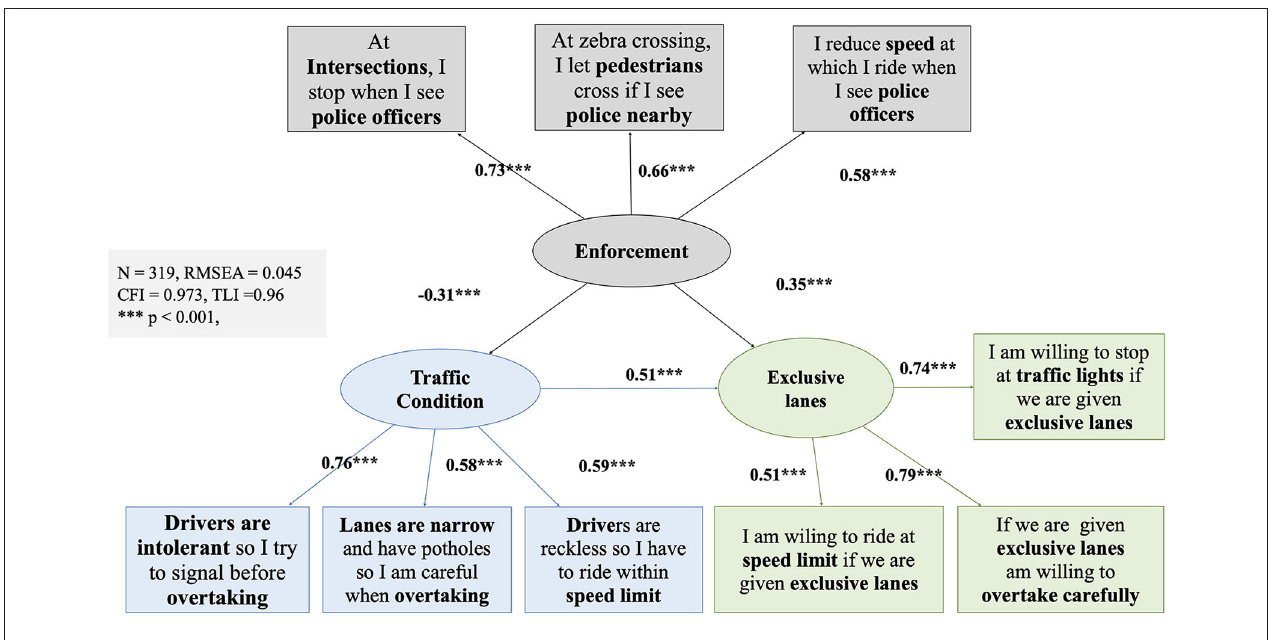
FIGURE 7 | Model 5—Effect of enforcement on exclusive